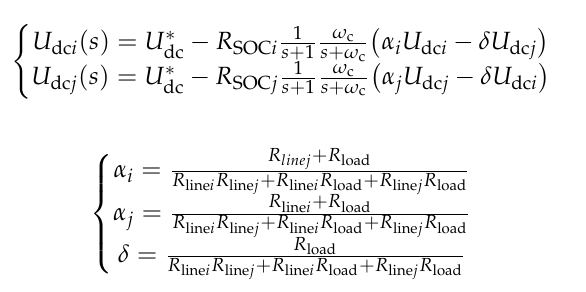
Figure 7. Equivalent model for stability analysis.